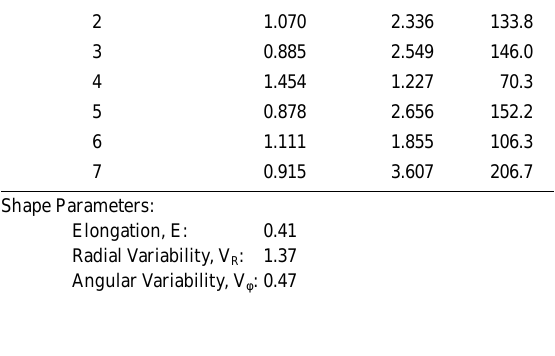
Table 1 Relative dimensions and calculated shape descriptors for the schematic particle profile shown in Figure 1 .